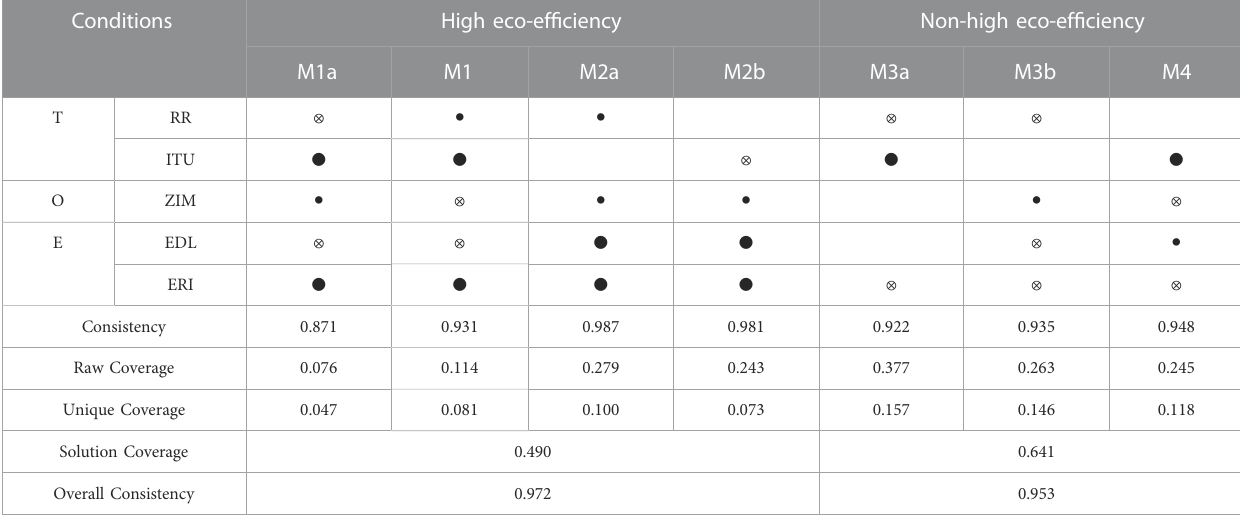
TABLE 5 Results of con fi gurational analysis with an enhanced consistency level. Conditions